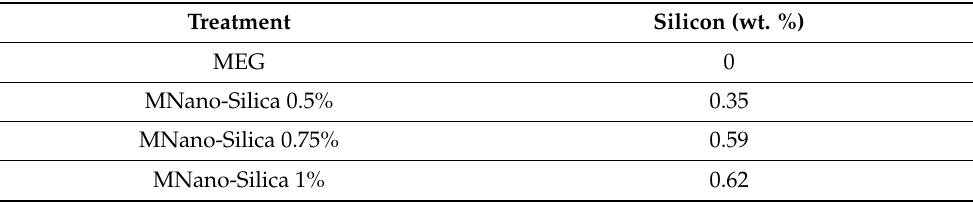
Figure 2. Morphology of wood ( a ) sengon MNano-Silica 0.75% and ( b ) sengon MNano-Silica 1%. Magnification 1000 × . Table 3. Chemical content of treated sengon wood.